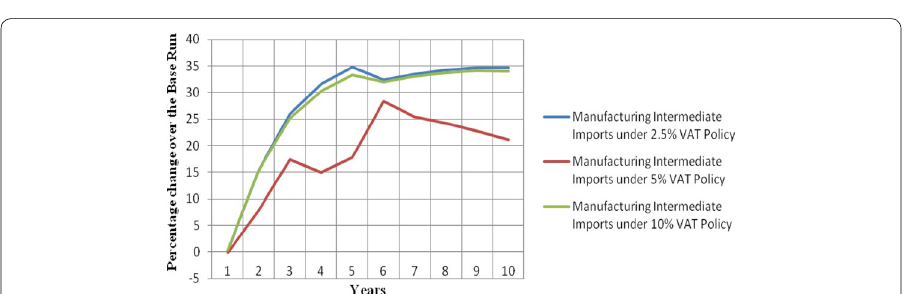
Fig. 41 Changes in manufacturing intermediate imports under varying VAT rates